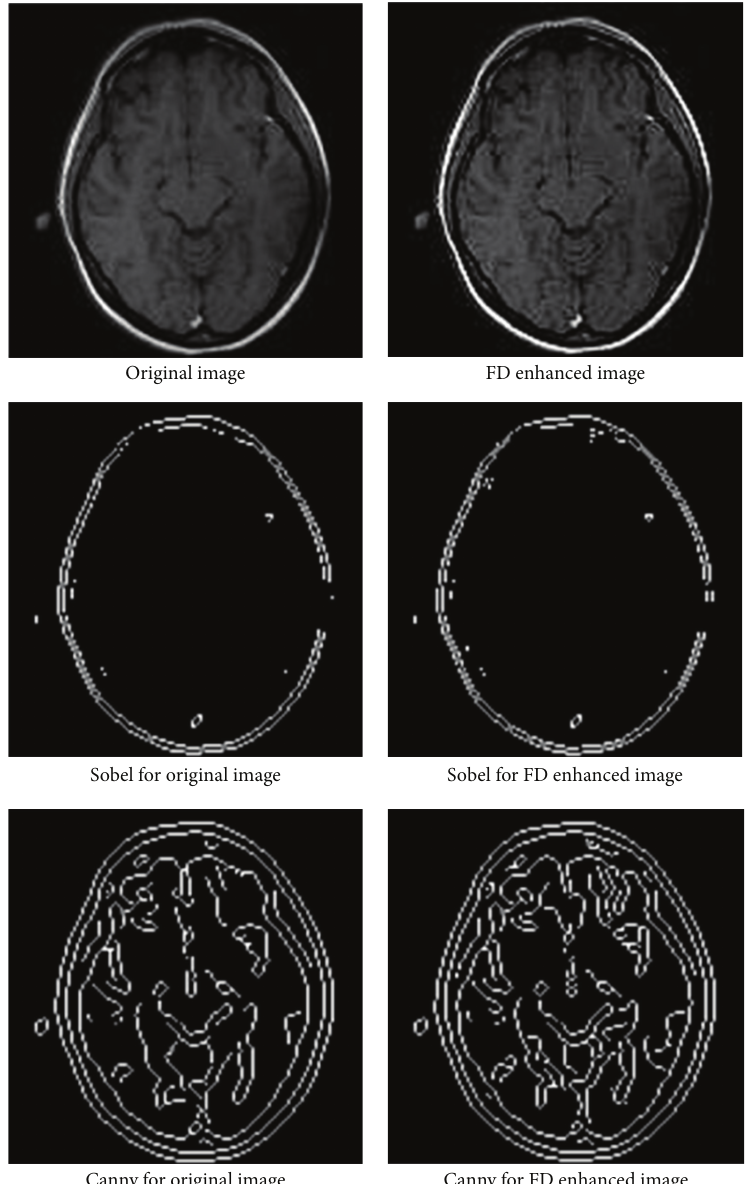
Figure 2: Results of the proposed enhancement algorithm by using FD masks for 𝜌 = 6 , 𝜇 = 0.05 , and 𝛼 = 0.1